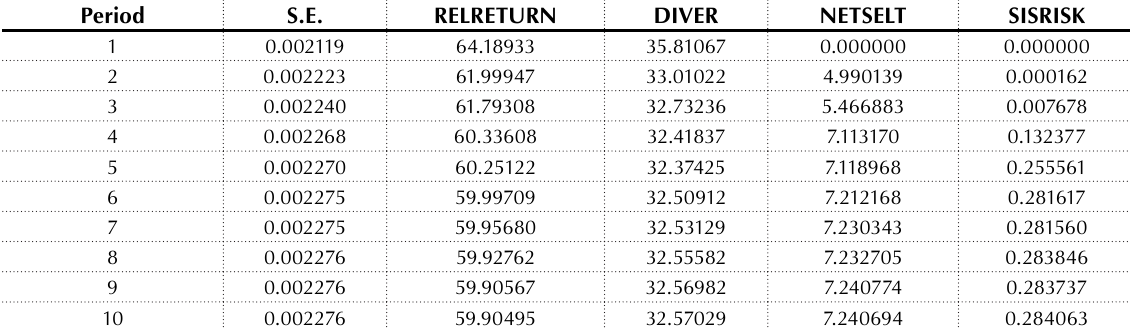
Table 4. Variance decomposition of DIVER